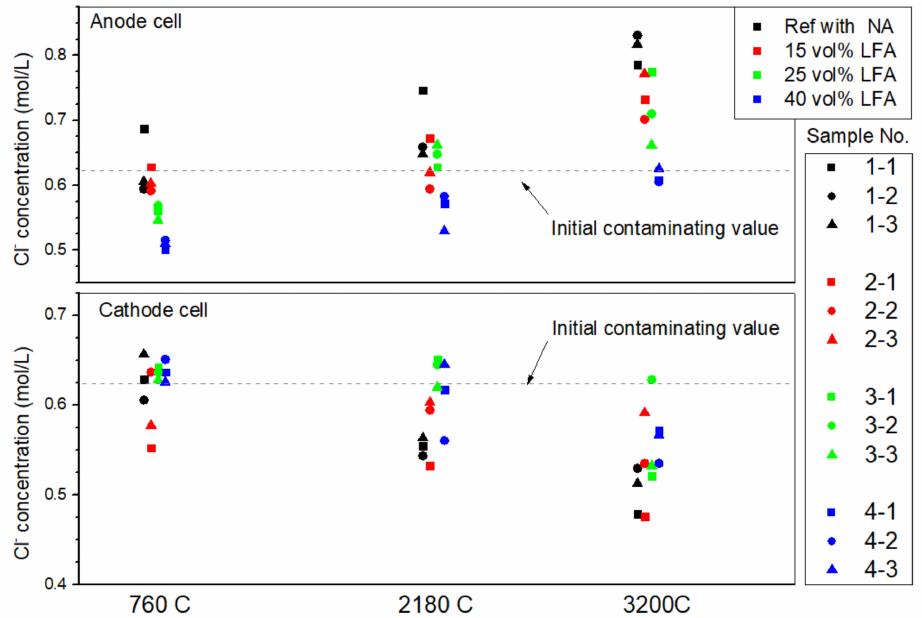
Figure 6. The measured chloride concentration of all simulated ICCP testing samples in different operation stages.